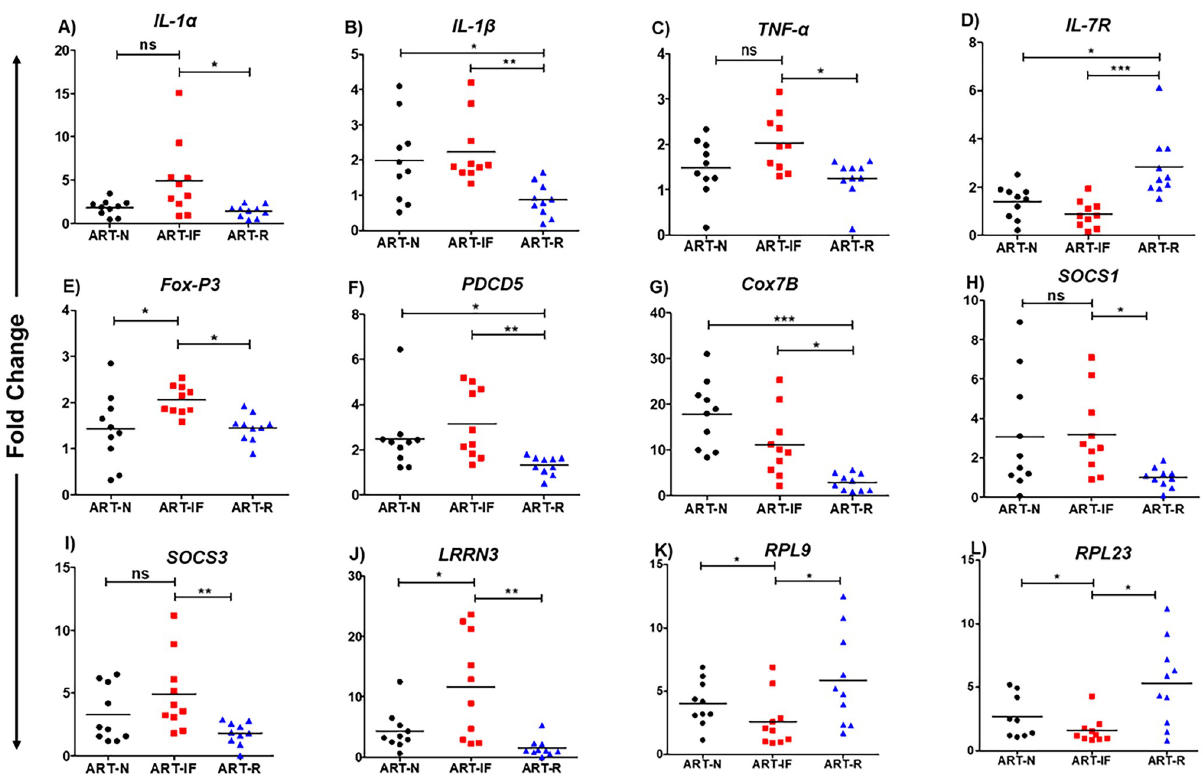
Fig 5. qRT-PCR analysis and validation of microarray gene expression data. Differentially expressed genes among study groups (ART-IF, ART-R, and ART-N) were shortlisted for validation. Scatter plots showing the fold change in expression profile for IL-1 α , IL-1 β , IL-7R , TNF- α , FoxP3 , PDCD5 , COX7B , SOCS1 , SOCS3 , LRRN3 , RPL9 , and RPL23 genes by qRT-PCR (n = 10 each group). Significant values are indicated by star ( � p < 0.05, �� p < 0.01, ��� p <